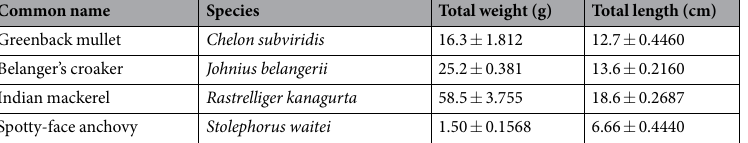
Table 1. Average total weight and length ± SD of the dried fish used in this study. Number of fish examined per species (n) =